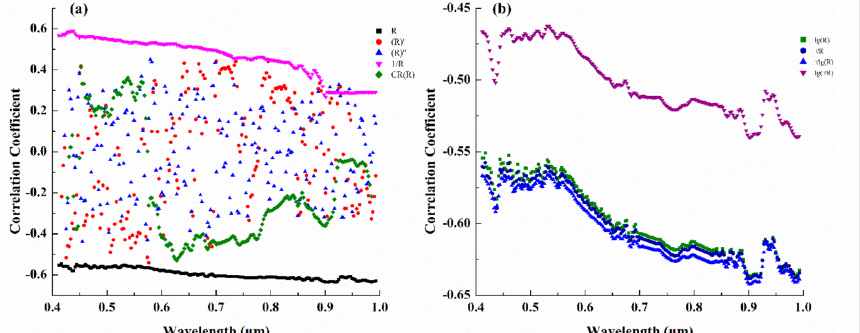
Figure 8. Correlation between di ff erent transform spectra and copper content: ( a ) five transformed